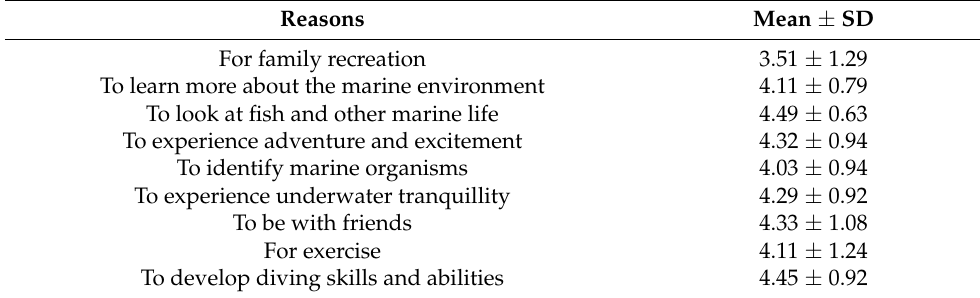
Table 1. Importance of the listed reasons for the participants’ diving activities.